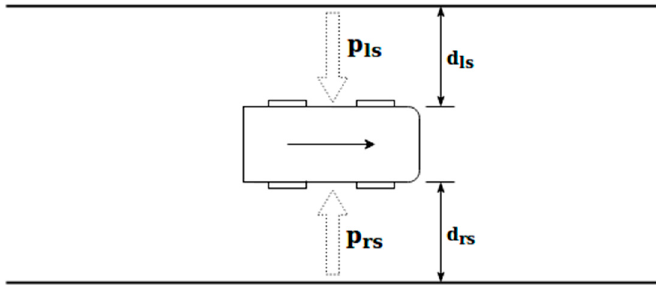
Figure 3. Scheme for the side potential field calculation.